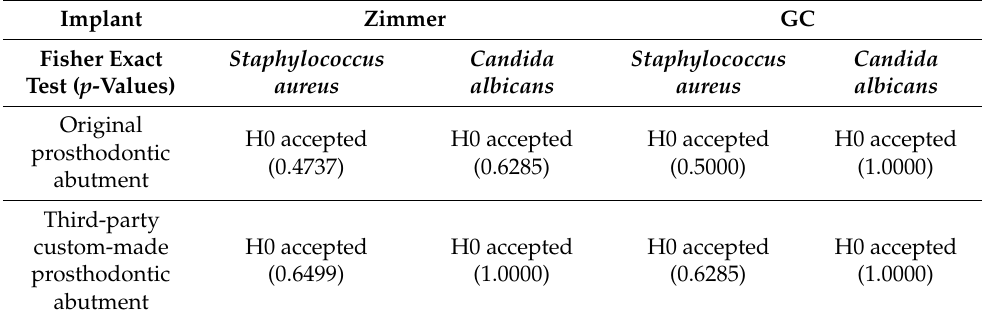
Table 3. Comparison of Fisher’s exact test values for microleakage between original and third-party custom-made prosthodontic